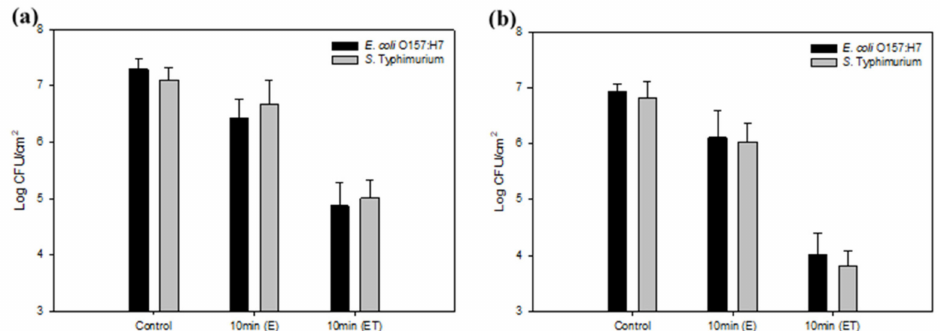
Figure 6. Biofilm formation of E. coli O157:H7 and S . Typhimurium in static ( a ) and dynamic ( b ) states. Populations of bacteria (log CFU / cm 2 ) attached to bare stainless steel, stainless steel electrochemically etched at 10 V for 10 min (E), and stainless steel electrochemically etched at 10 V for 10 min with Teflon coating